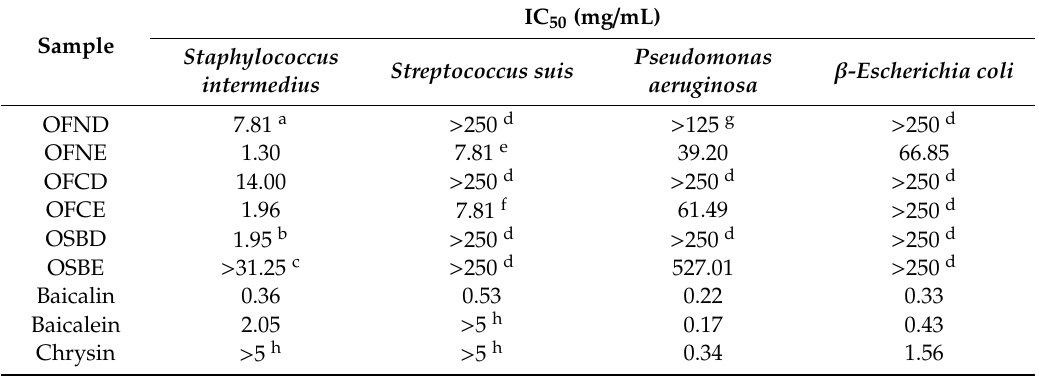
Table 1. Half maximal inhibitory concentrations (IC 50 ) of Oroxylum indicum extracts and flavones. IC 50 (mg / mL) Sample Pseudomonas Staphylococcus β -Escherichia coli Streptococcus suis aeruginosa intermedius OFND 7.81 a OFNE OFCD